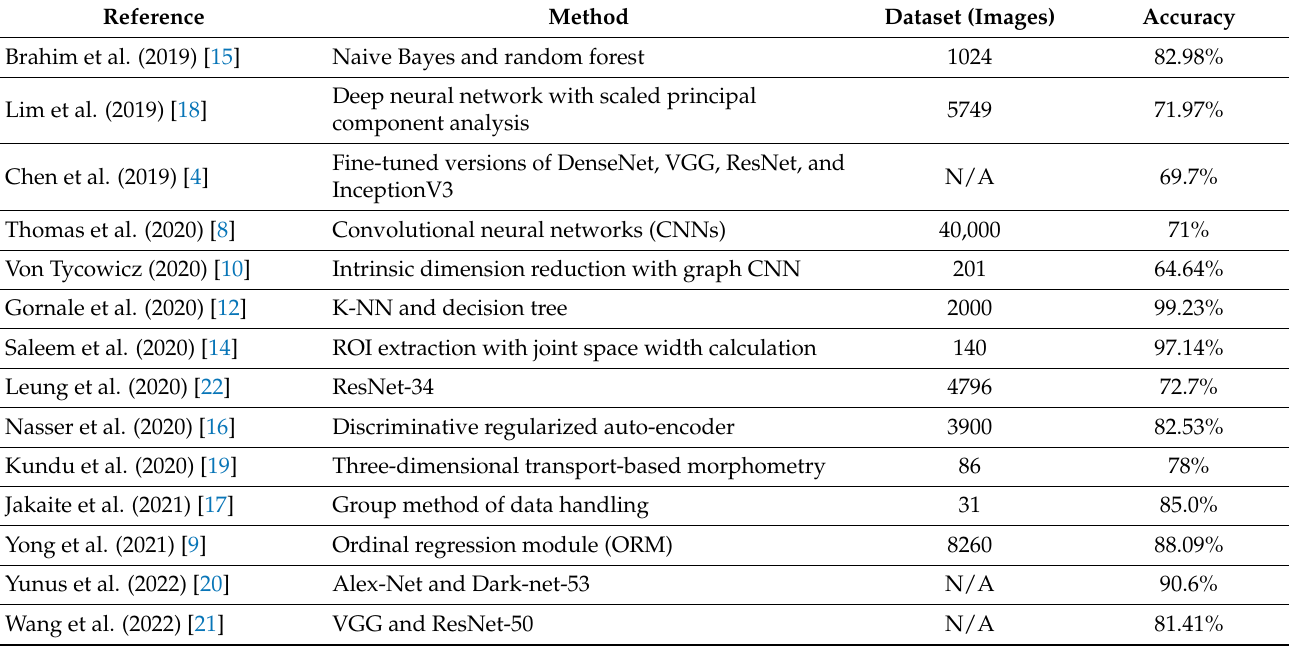
Table 1. Summary of